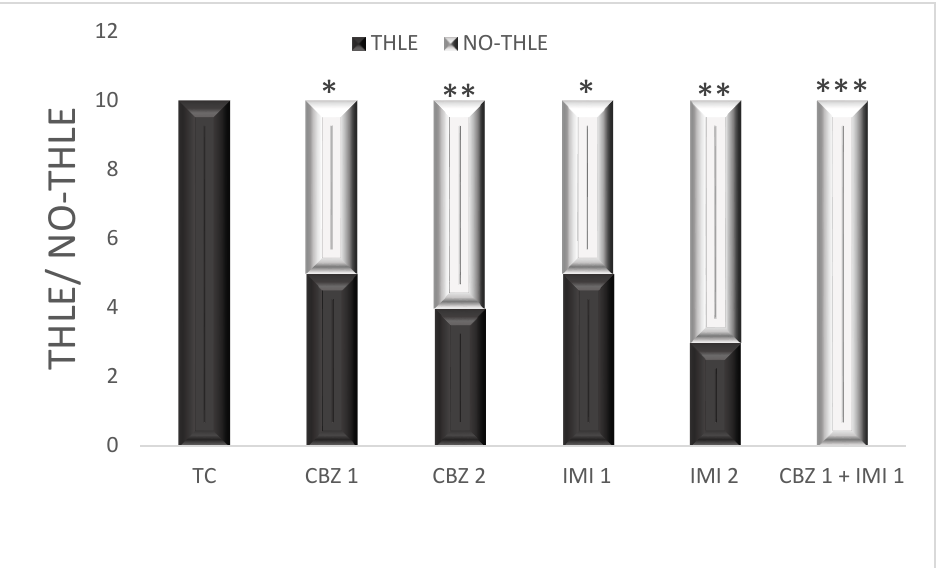
Figure 1. The effect of CBZ (20 and 50 mg/kg), IMI (10 and 20 mg/kg) and CBZ (20 mg/kg) + IMI (10 mg/kg) on MES-induced THLE. Statistical significance between toxic control and other groups was computed using Fisher’s exact test (one tailed). ( p < 0.05 *, p < 0.01 **, p < 0.001 *** significance levels). CBZ, IMI, and TC indicate carbamazepine, imipramine , and toxic control, respectively.